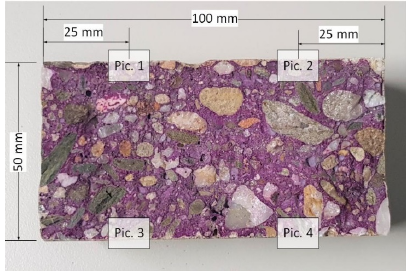
Figure 7. Position of the microscopic pictures on the fracture surface of an acid-stored test specimen after spraying on the phenolphthalein